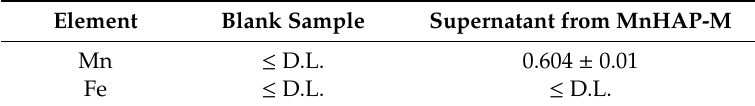
Table 4. Iron and manganese leaching (as determined by AAS). Results are presented in mg/L. limit (D.L.)—0.1 mg / L for both Detection limit (D.L.) — 0.1 mg/L for both elements.